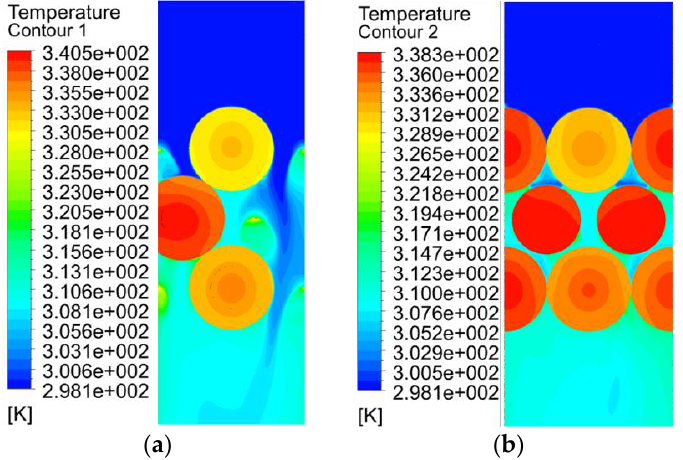
Figure 5. The temperature field of the pebble at ( a ) the middle plane and ( b ) the diagonal plane.